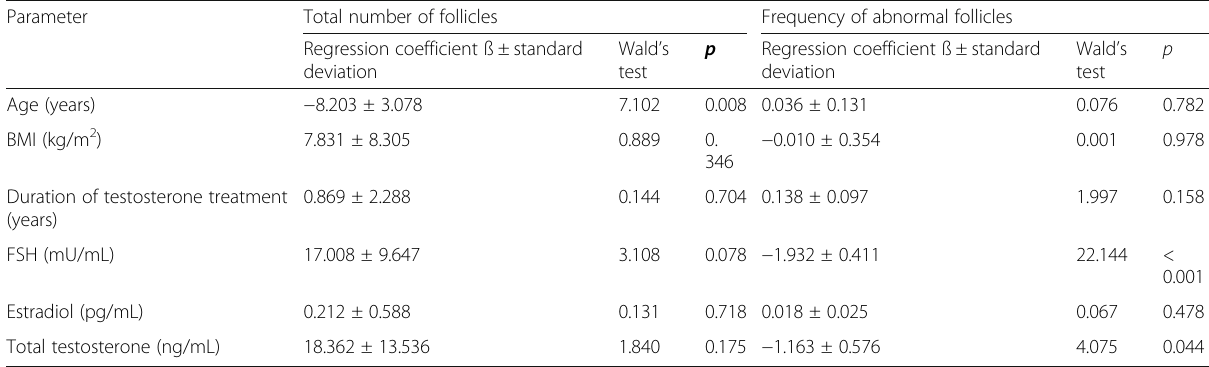
Table 2 Parameters associated with the total number of follicles and the frequency of abnormal follicles (histomorphological analysis): results of a generalized linear model